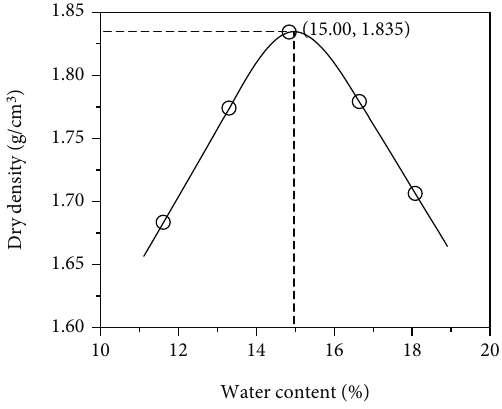
Figure 3: Compaction curve of soil after